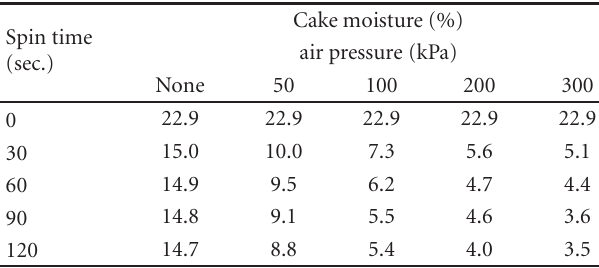
Table 5: E ff ects of G -force and air pressure on the dewatering